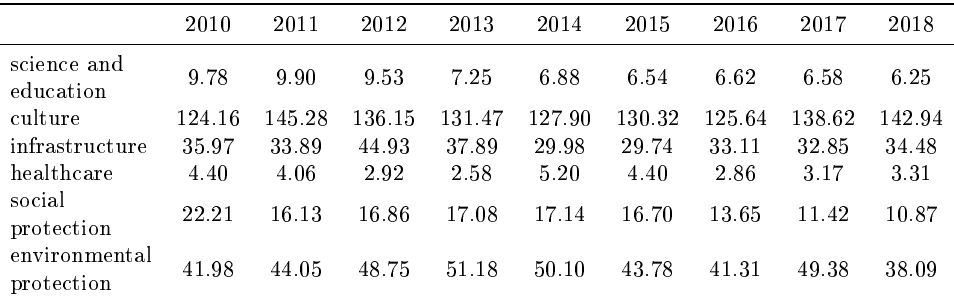
Table 4: Coe(cid:30)cient of variation (Vs) of expenditure of government institutions in individual voivodeships, by area, %